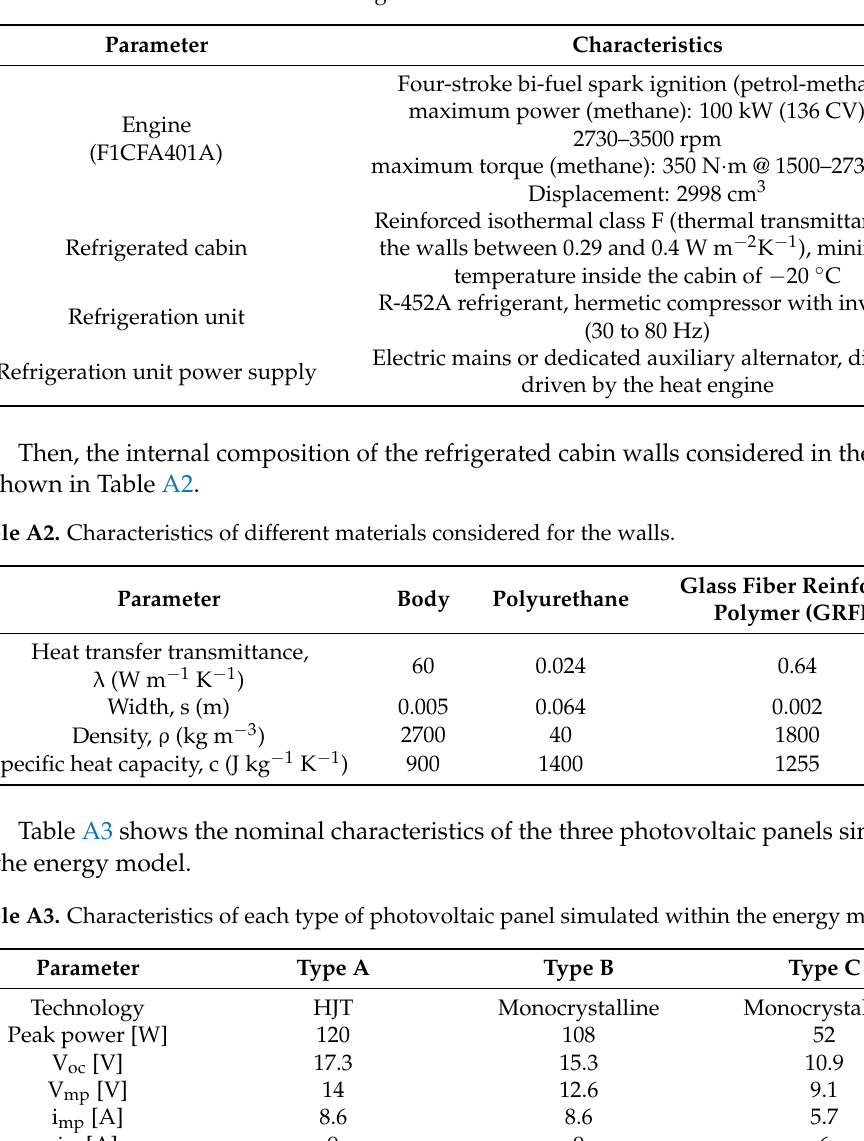
Table A1. Main characteristics of the refrigerated van.